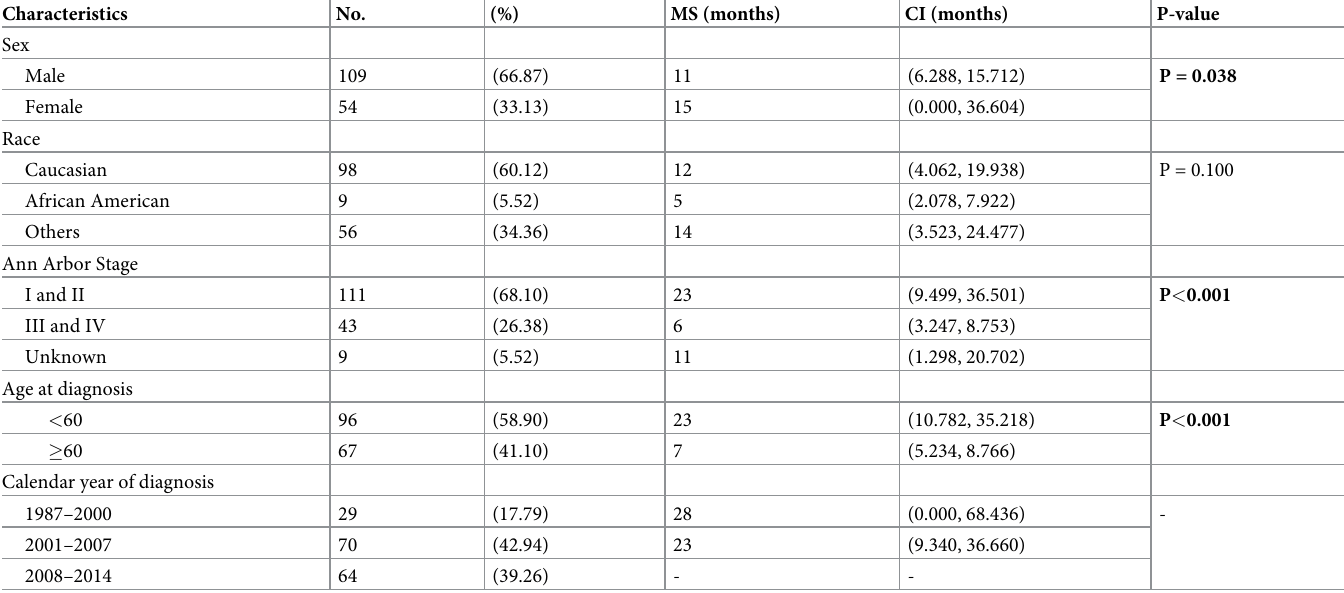
Table 1. Distributions of characteristics of patients with extra nodal natural killer/T-cell lymphoma, nasal type.